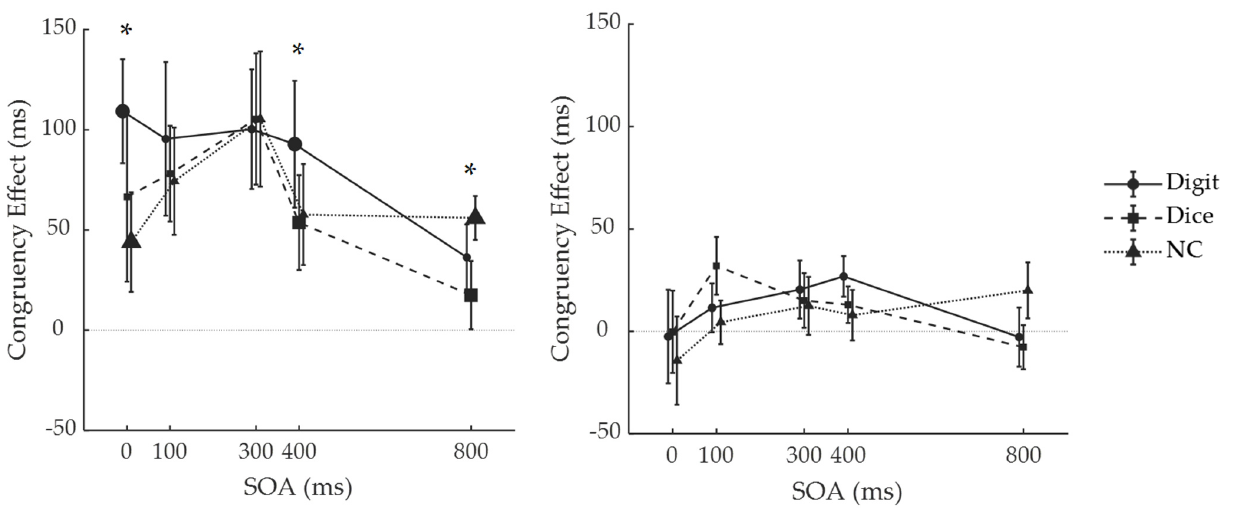
Figure 4. Congruency effect of three number notations as a function of SOA, for ( a ) synesthetes; ( b ) non-synesthetes. Error bars denote one standard error. The stars (*) indicate p < 0.05 for the test of simple main effects. The conditions where congruency effects were significantly different were marked with enlarged symbols.